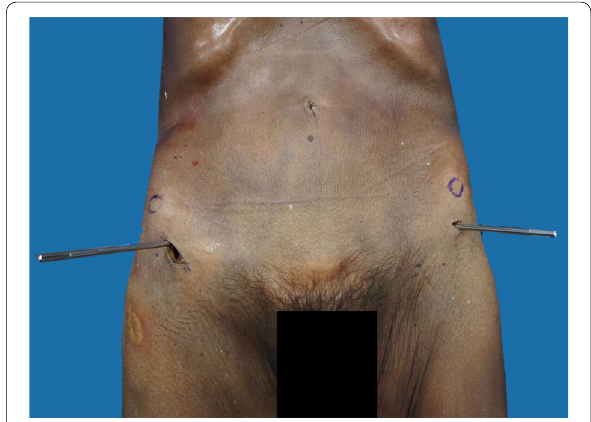
Fig. 3 Open-technique pin placement on the right hemipelvis and percutaneous technique on the left hemipelvis